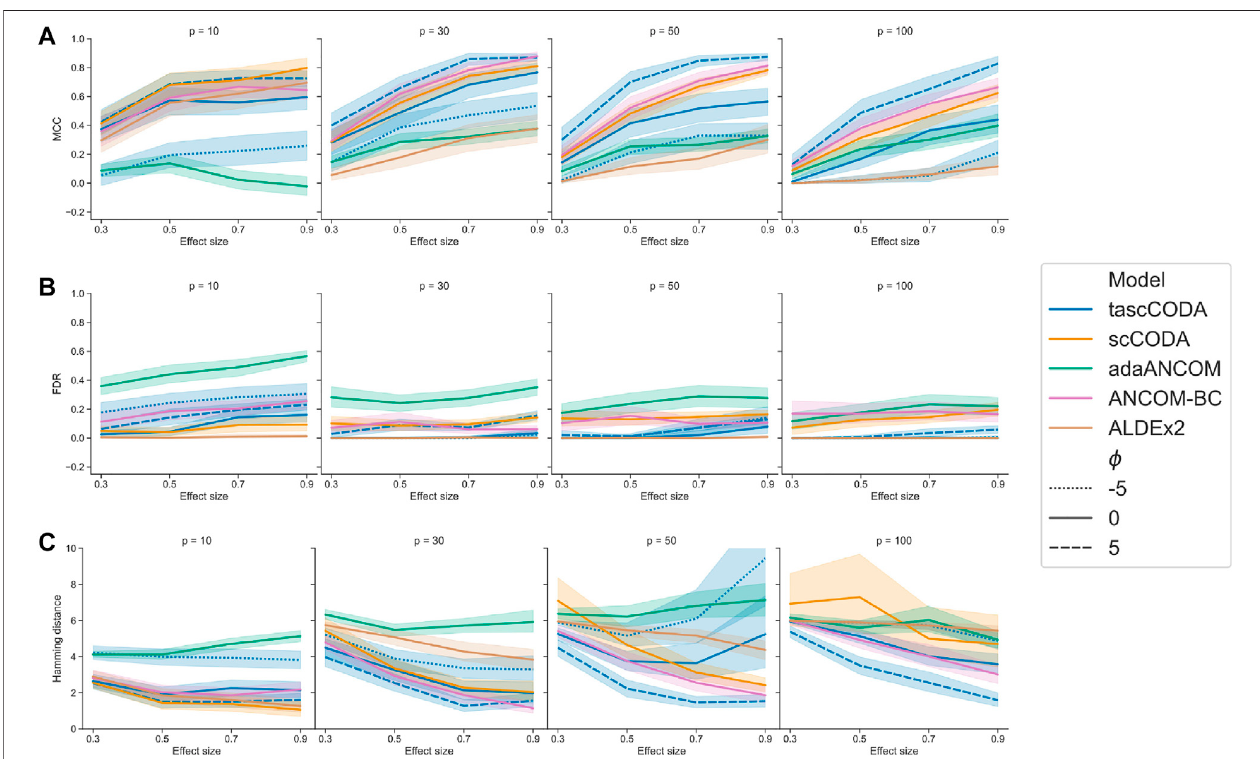
FIGURE 2 | Performance comparison of tascCODA and other methods on simulated data with one binary covariate (differential abundance testing). Plots are groupedbythenumberofsimulatedcomponents p andtheeffectsize β .FortascCODA,differentvaluesof ϕ weretested(dashedbluelines).Theareasaroundeachline represent the standard deviation. Performance measured by (A) Matthews correlation coef fi cient (MCC). (B) False discovery rate (FDR) (C) Hamming distance between ground truth and determined